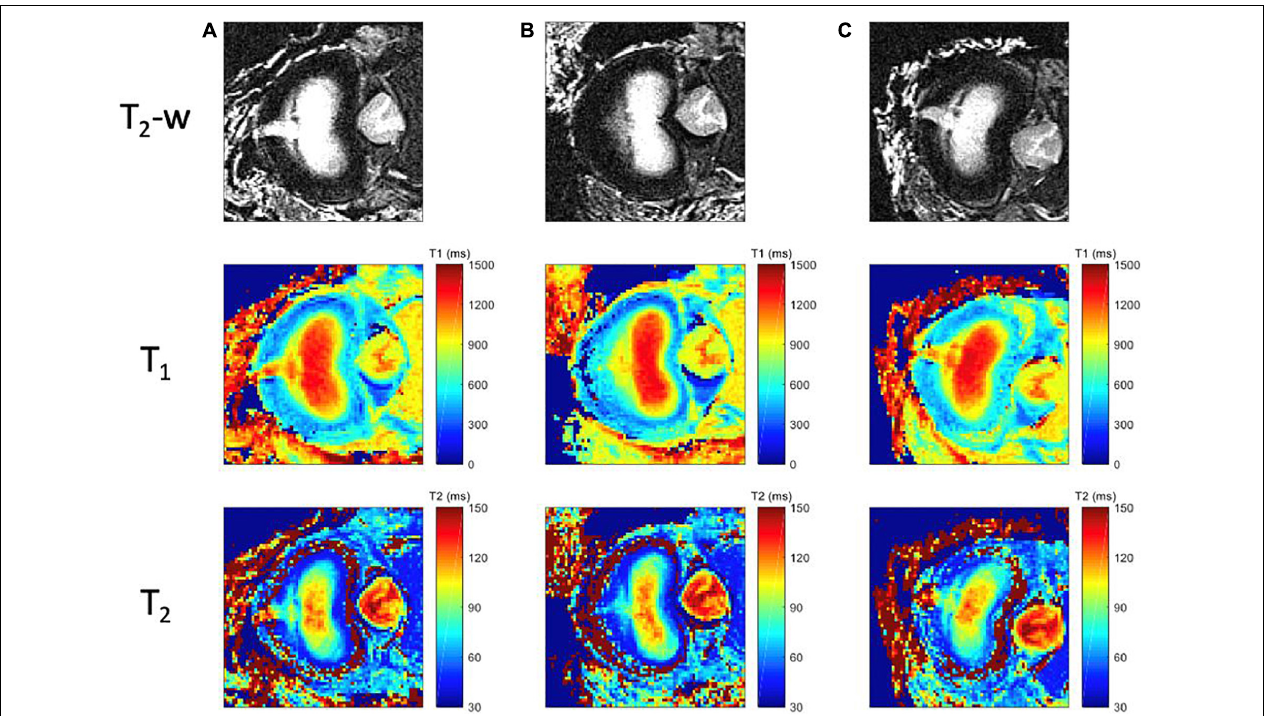
FIGURE 6 | MR images for each mechanical loading state of the specimen with radial tear. First row corresponds to the T 2 -weighted images; the second row to T 1 maps, with a scale ranging from 0 ms (blue) to 1500 ms (red); and third row to the T 2 maps, with a scale ranging from 20 ms (blue) to 150 ms (red); for three different